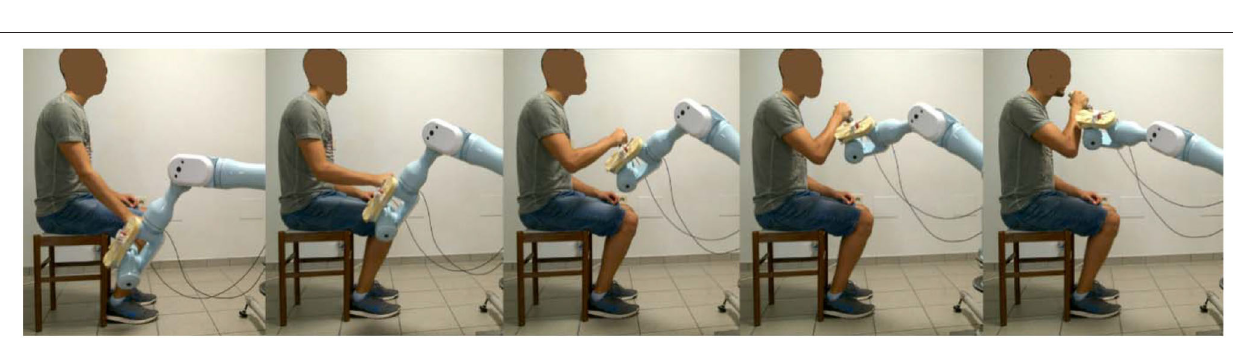
FIGURE 2 | Assisted RM: starting with the robot handle just above the thigh, the assisted Reaching Movement (RM) consisted of compound movements of shoulder flexion and elbow extension, getting as far as 90 degrees of shoulder flexion and fully extended elbow were reached.